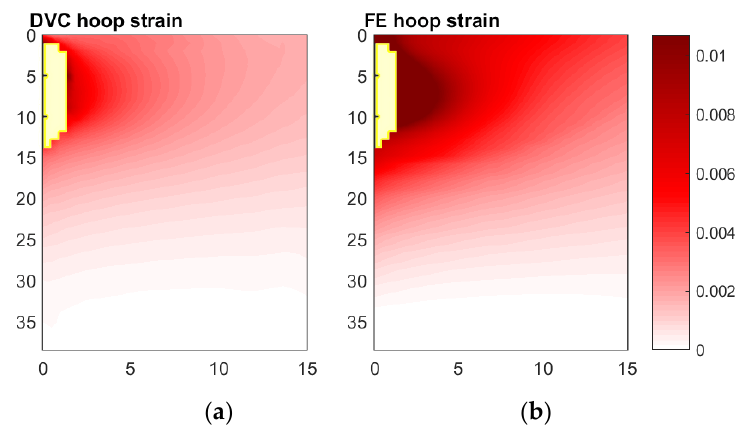
Figure 11. Comparison of hoop strain fields measured and predicted, Digital Volume Correlation ( a ) and Finite Element ( b ), for Displacement Step 3 relative to reference scan. Measurements with correlation coefficients below 0.9 have been excluded from both fields, at spatial locations shown in yellow.